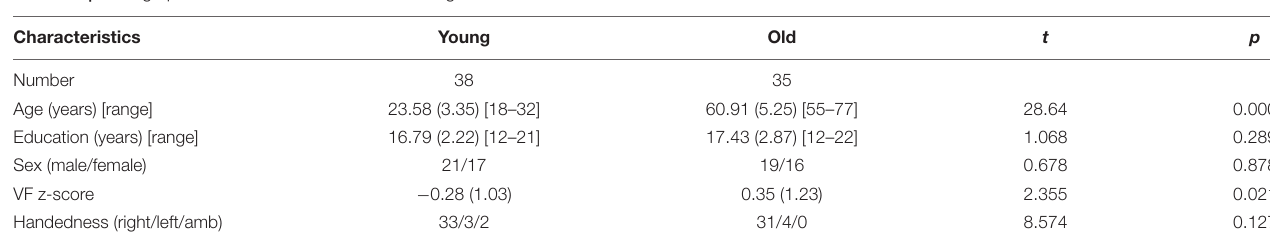
TABLE 1 | Demographic data and differences of VF testing.